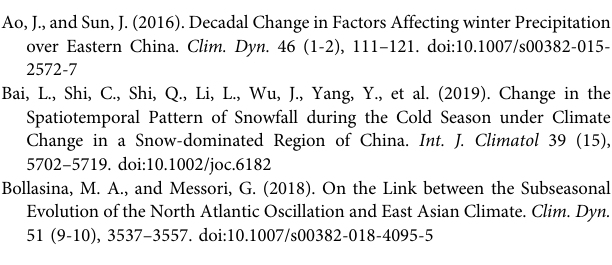
Frontiers in Earth Science |